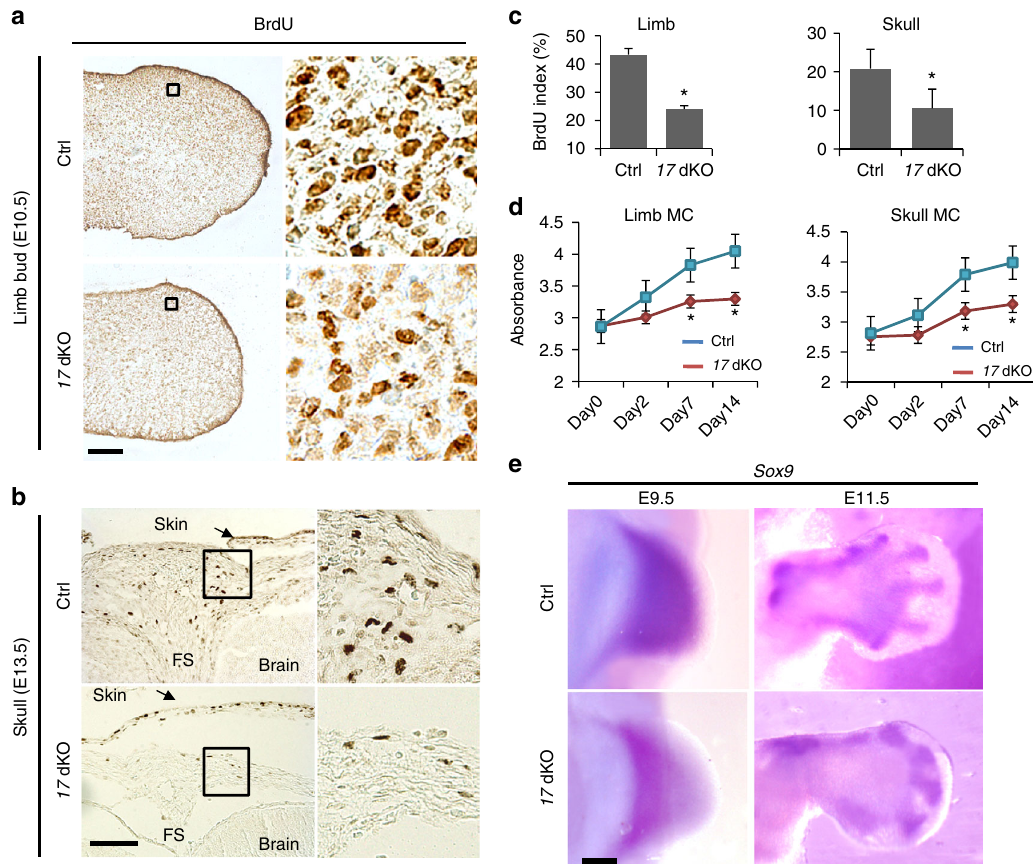
Fig. 2 Proliferation defect in cells missing Mir17-92 and Mir106b-25 . a – d Loss of Mir17-92 and Mir106b-25 ( 17 dKO) impairs skeletal mesenchymal cell proliferation. Since Mir106b-25 -null mice show no skeletal abnormalities, Mir106b- null mice were used as the control. a BrdU labeling on limb bud sections of Mir17-92 fl / fl :Mir106b-25 − / − (Ctrl) and Prx1-Cre:Mir17-92 fl / fl :Mir106b-25 − / − ( 17 dKO) embryos at embryonic day (E) 10.5. b BrdU labeling of coronal skull sections of Ctrl and 17 dKO embryos at E13.5. c The BrdU-positive cells were signi fi cantly reduced in the 17 dKO limb bud and skull mesenchyme ( n = 6, * p < 0.05). d Cell proliferation assay on limb bud and skull mesenchymal cells (MC) in vitro. Primary mesenchymal fi broblasts isolated from Mir17-92 fl / fl : Mir106b-25 − / − embryos were transduced with adenoviruses expressing a Cre recombinase ( 17 dKO) or a yellow fl uorescent protein (Ctrl) to delete Mir17- 92 in vitro. The ef fi cient reduction (85 ± 5%) in miR-17-92 miRNAs was con fi rmed by qRT-PCR. Mir17-92 -de fi cient limb bud and calvarial mesenchymal cells showed signi fi cantly impaired proliferation over time compared with control, as assessed by an index of the increase in cell mass ( n = 5, * p < 0.05). e Whole-mount in situ hybridization for Sox9 shows a reduction in size of the Sox9 -positive domain at E9.5 and E11.5. FS frontal suture. Scale bar, 100 μ